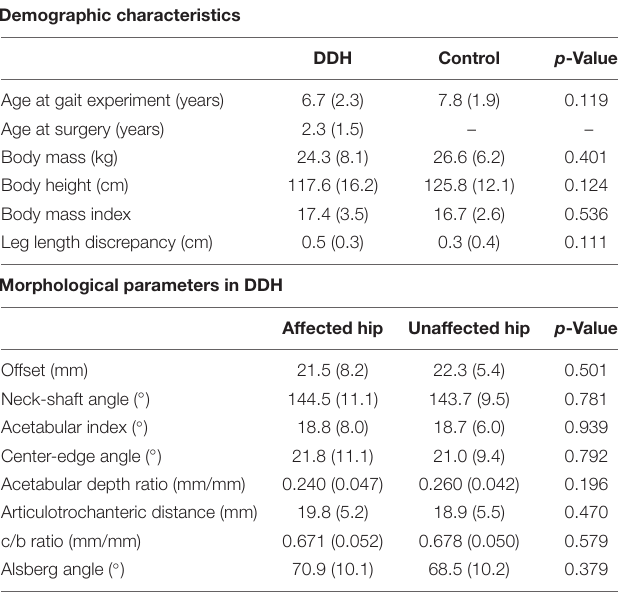
TABLE 1 | Means (standard deviations) of the demographic characteristics of the Control group and the juvenile patients treated for unilateral developmental dysplasia of the hip (DDH) during toddlerhood, as well as the morphological parameters of the hips in the DDH